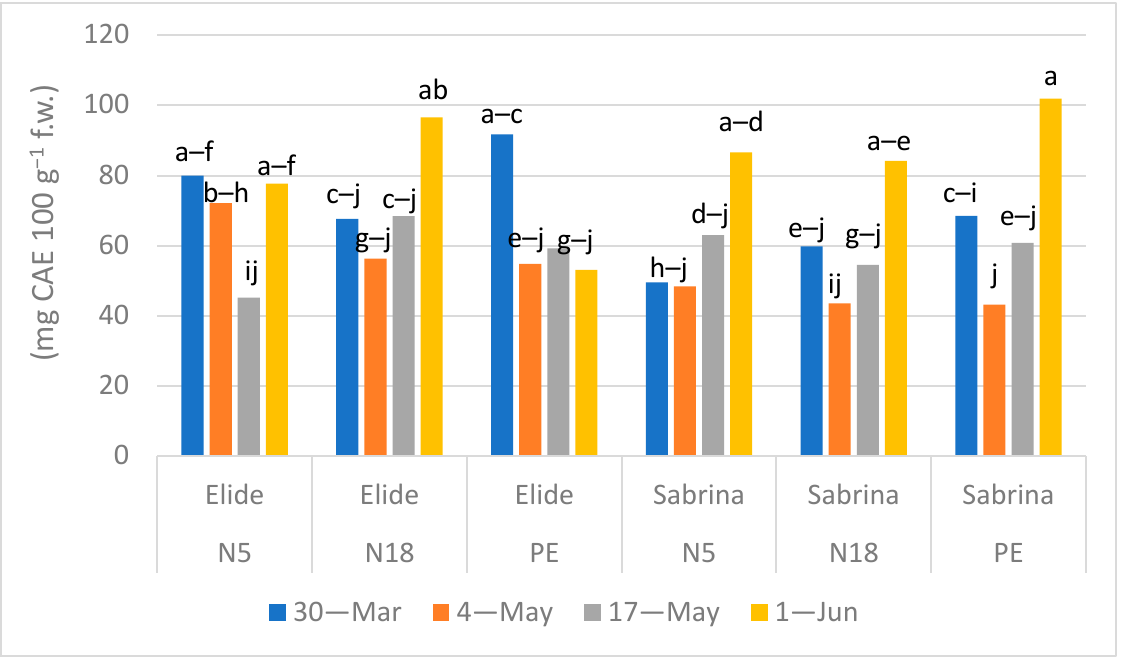
Figure 5. Effect of Mulch × Cultivar × Time of sampling interaction ( p < 0.0001) in flavonoids content (mg CAE 100 g − 1 f.w.). Means followed by the same letters do not differ significantly according to Tukey HSD Test ( p = 0.05).